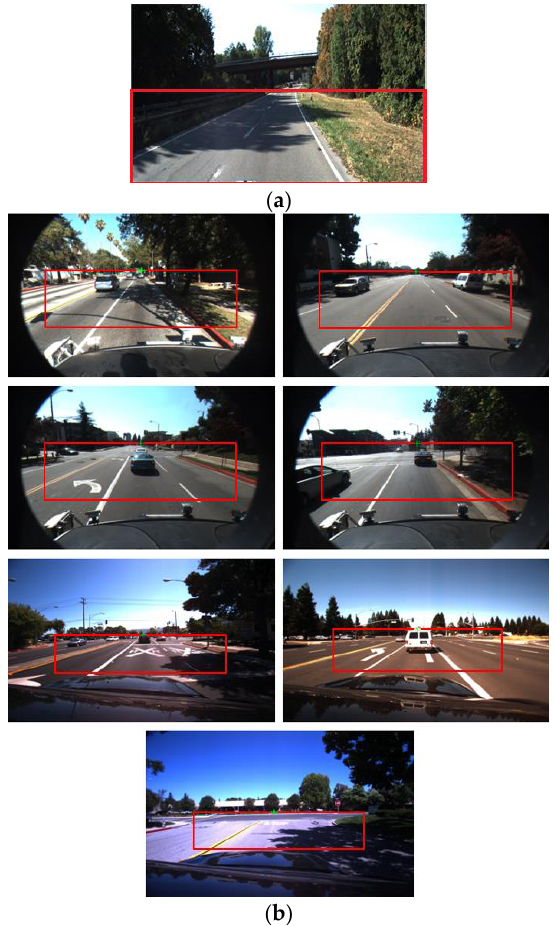
Figure 3. Predetermined ROI, and automatically defined ROI based on vanishing point within the input image: ( a ) Predetermined ROI; ( b ) Automatically defined RO with the detected vanishing point of green cross shape. Sensors 2017 , 17 , 2475